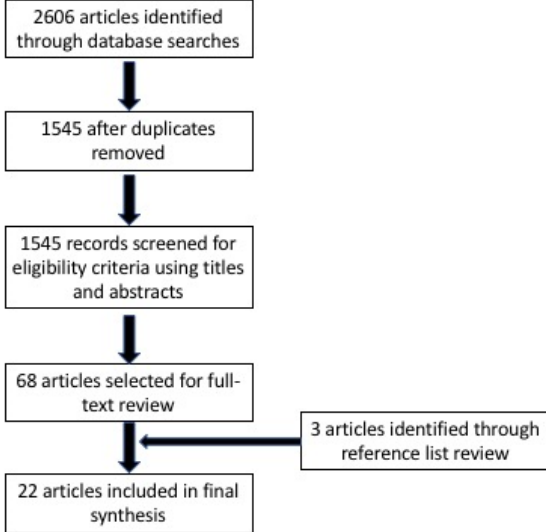
Figure 1. Flow diagram for article selection